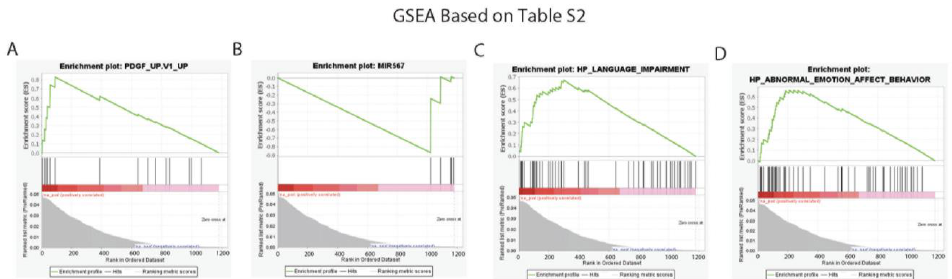
Figure 4. Enrichment plots from the gene set enrichment analysis: ( A , B ) are enrichment plots based